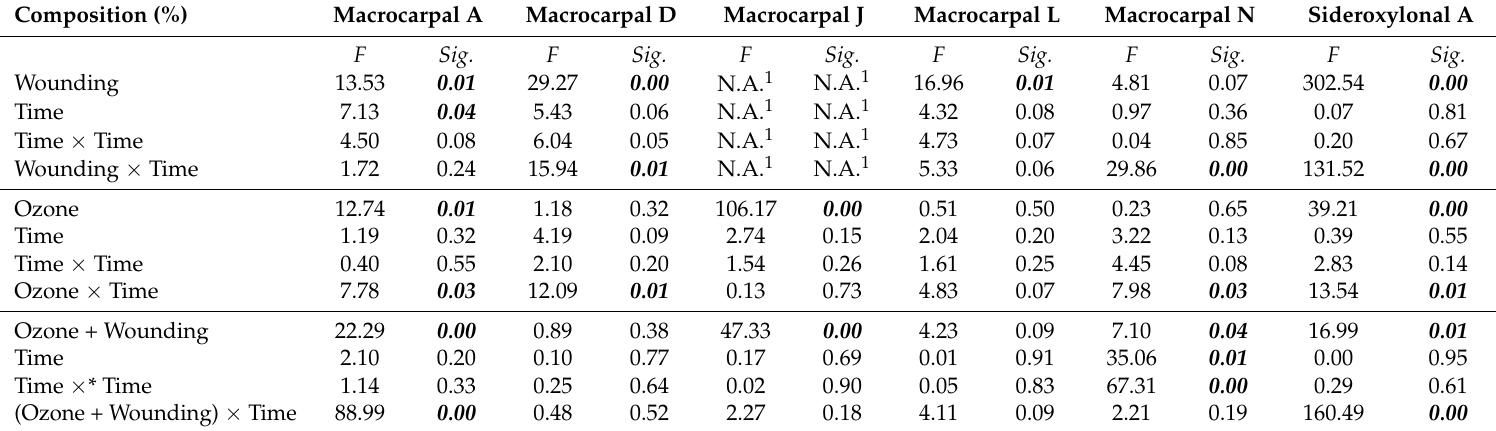
Table 4. Summary of the linear mixed model for the statistical effects of treatments (wounding, O 3 , and O 3 + wounding) and different recovery times on the composition of individual FPCs in total FPCs in E. globulus leaves. Significant values are shown in italic and bold ( n = 3, Sig. < 0.05). Composition